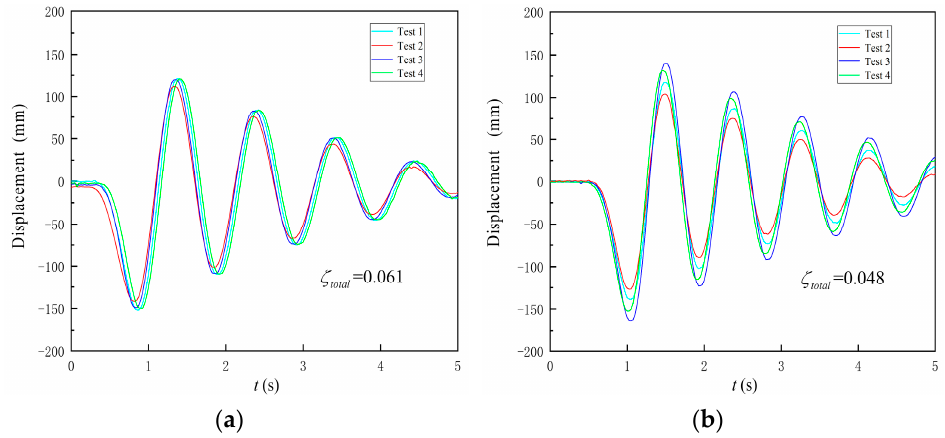
Figure 8. Free decay tests. ( a ) K = 1400 N/m; ( b ) K = 1800 N/m.